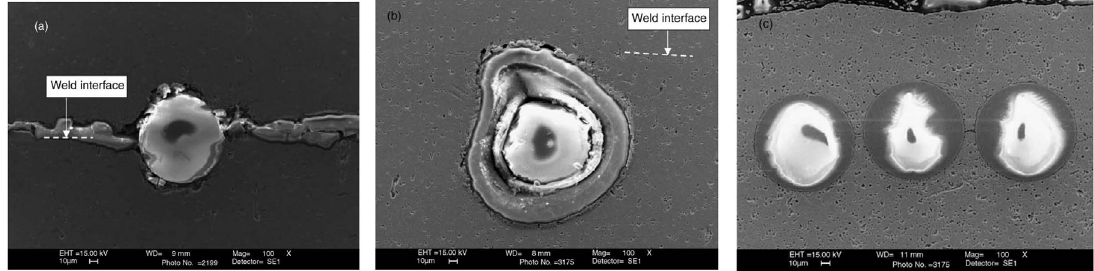
Figure 17. ( a ) Dispersal of polymer coating under full and partial load conditions, ( b ) coating remains but distorted in no load embedding and ( c ) full consolidation with polymer costing removed prior to consolidation [8].